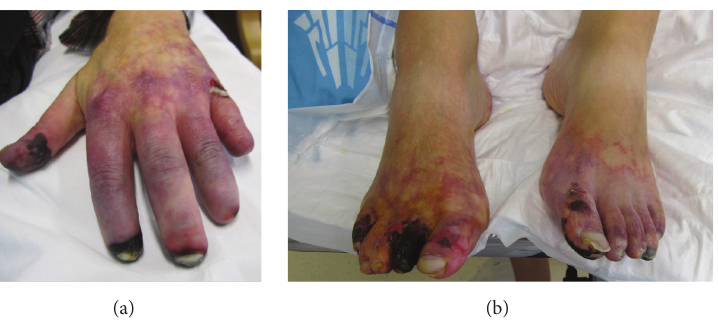
Figure 1: Acral ulcers. Painful, necrotising ulcers on hands (a) and feet (b). Note the amputation of distal phalanxes 4 and 5 of the left hand.